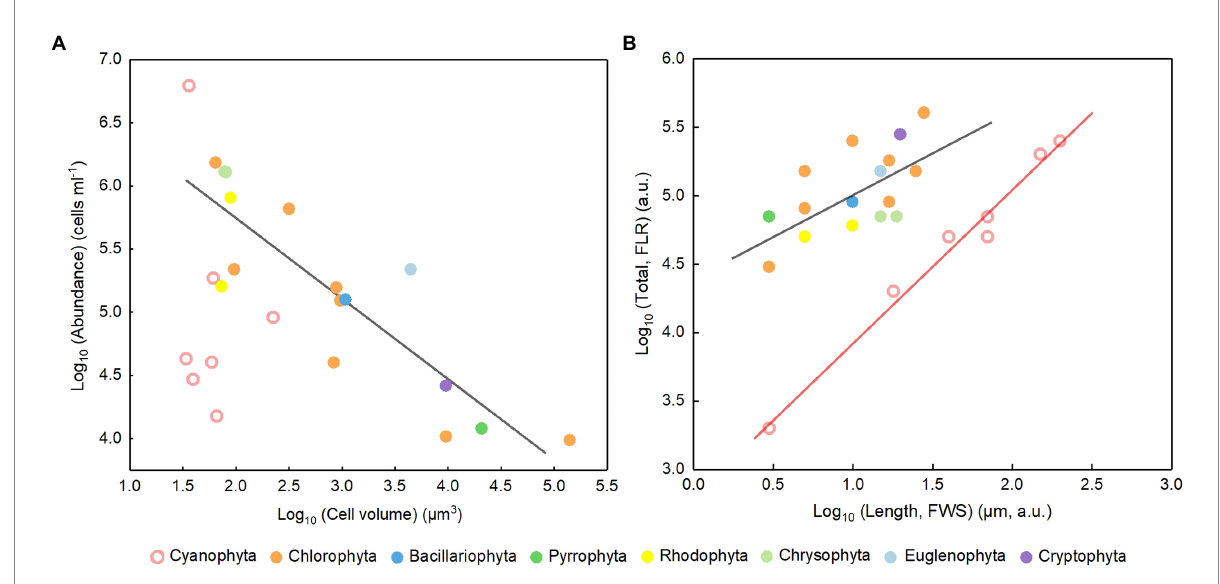
FIGURE 1 (A) Algal cell volume versus abundance in the normal culture experiment. The regression for algae except Cyanophyta: y = − 0.64 x + 7.02, adjusted r 2 = 0.74, p < 0.01. (B) FLR area per cell versus FWS length per cell. FLR, red fluorescence; FWS, forward scatter. The regression for eukaryotic algae (black line): y = 0.59 x + 4.43, adjusted r 2 = 0.35 , p < 0.01; the regression for Cyanophyta (red line): y = 1.12 x + 2.80, adjusted r 2 = 0.98, p < 0.001.